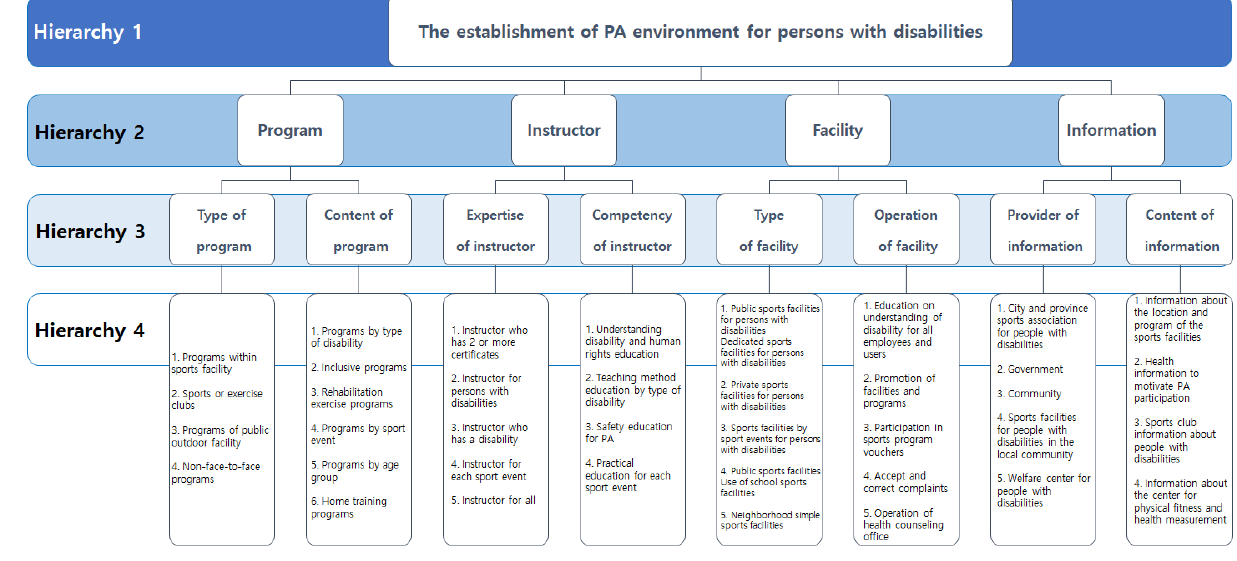
Figure 1. The hierarchical structure of the questionnaire.